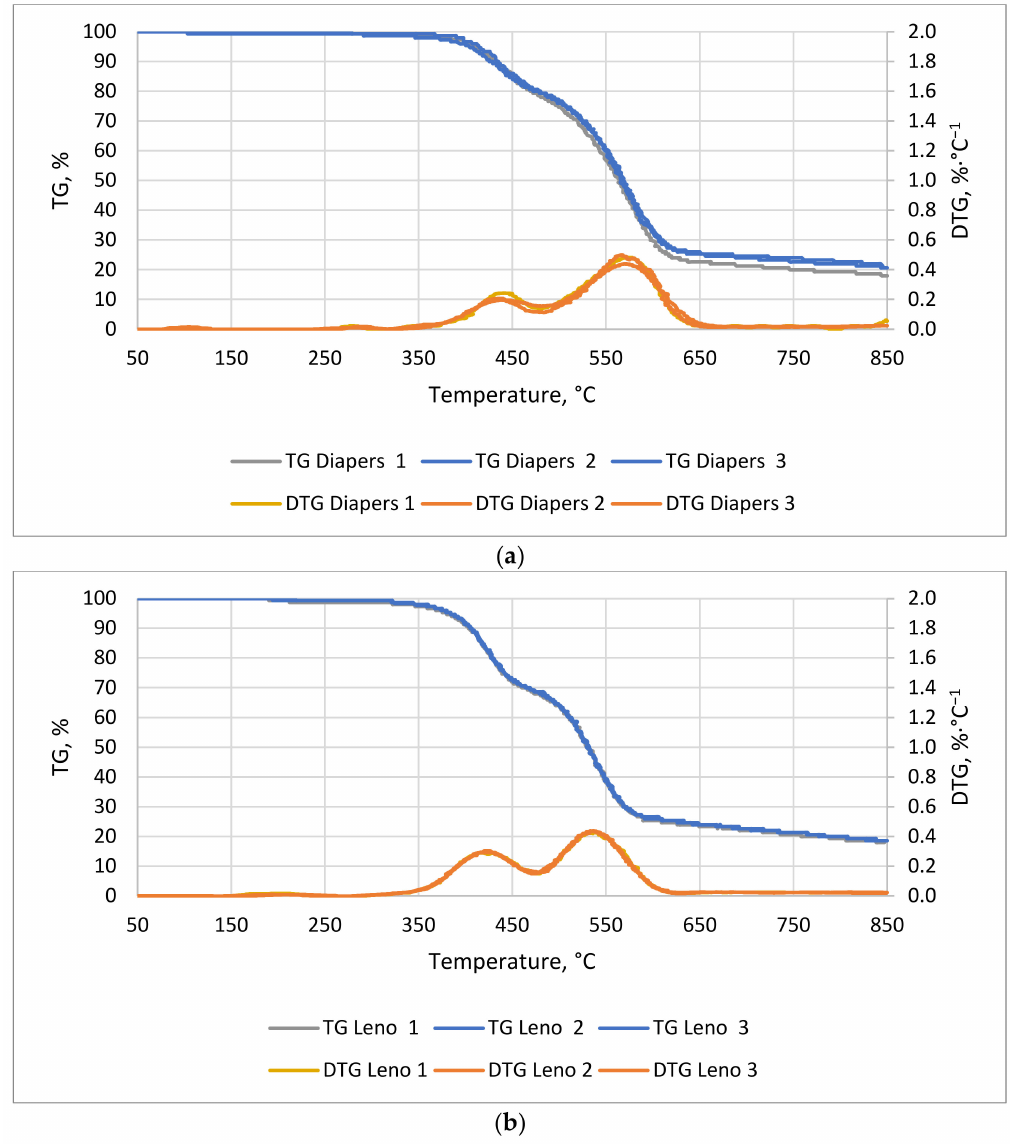
Figure 9. Characteristics of the TG/DTG of hygiene waste: ( a ) diapers; ( b )